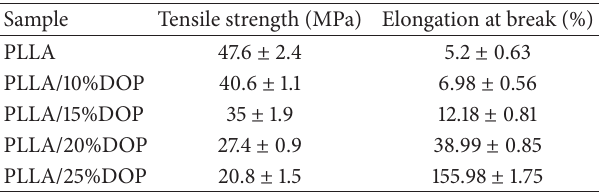
Table 1: Mechanical properties of PLLA and PLLA/DOP samples.